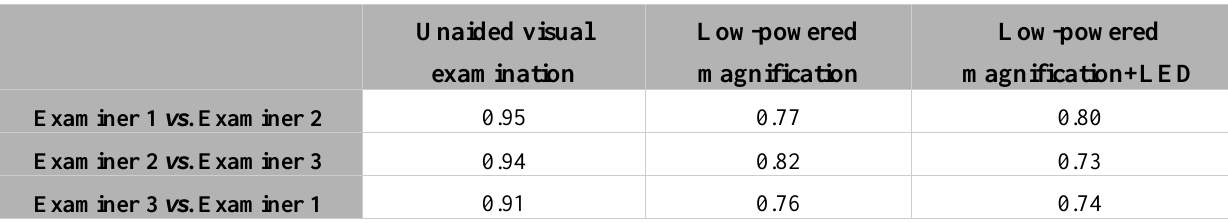
Table 6. Interexaminer reproducibility of ICDAS examinations (Weighted Kappa) for Permanent